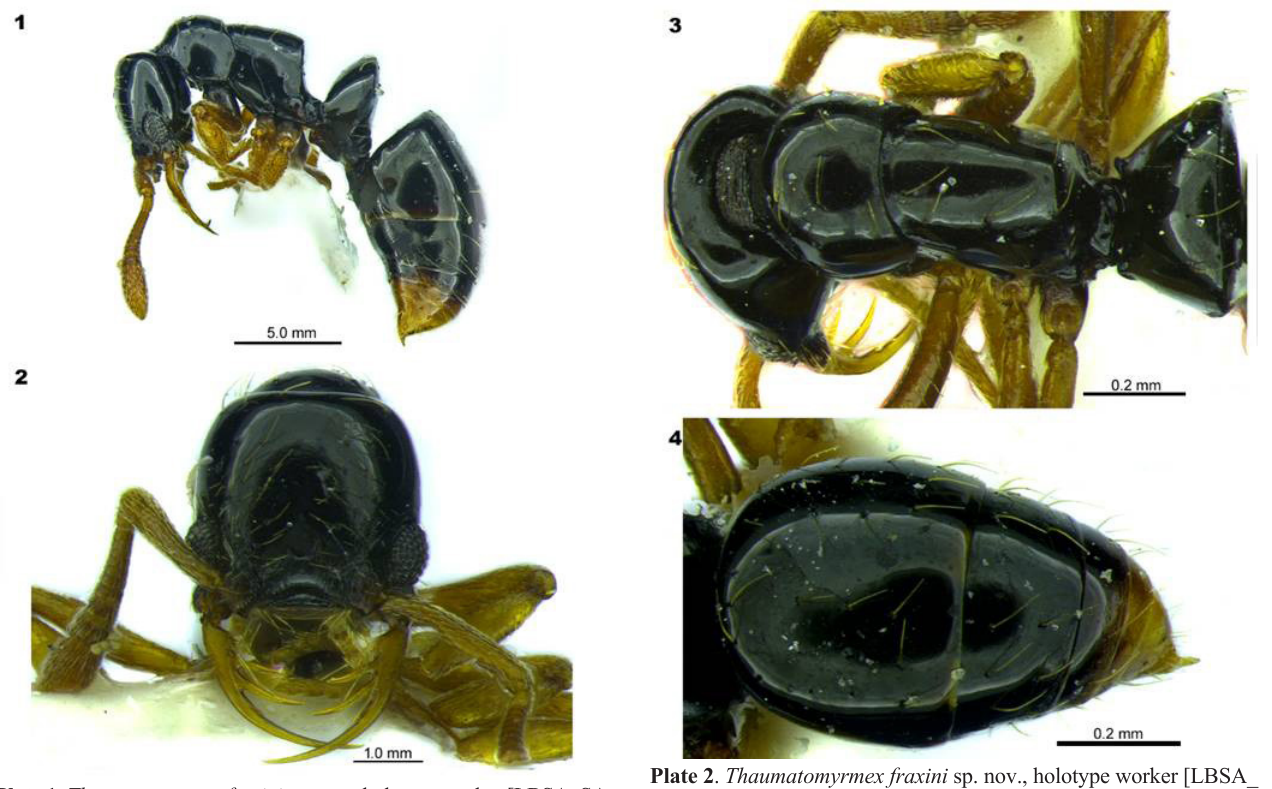
Plate 1 . Thaumatomyrmex fraxini sp. nov., holotype worker [LBSA_SA _14015217]. Fig. 1: habitus, left lateral view. Fig. 2: head, dorsal view.